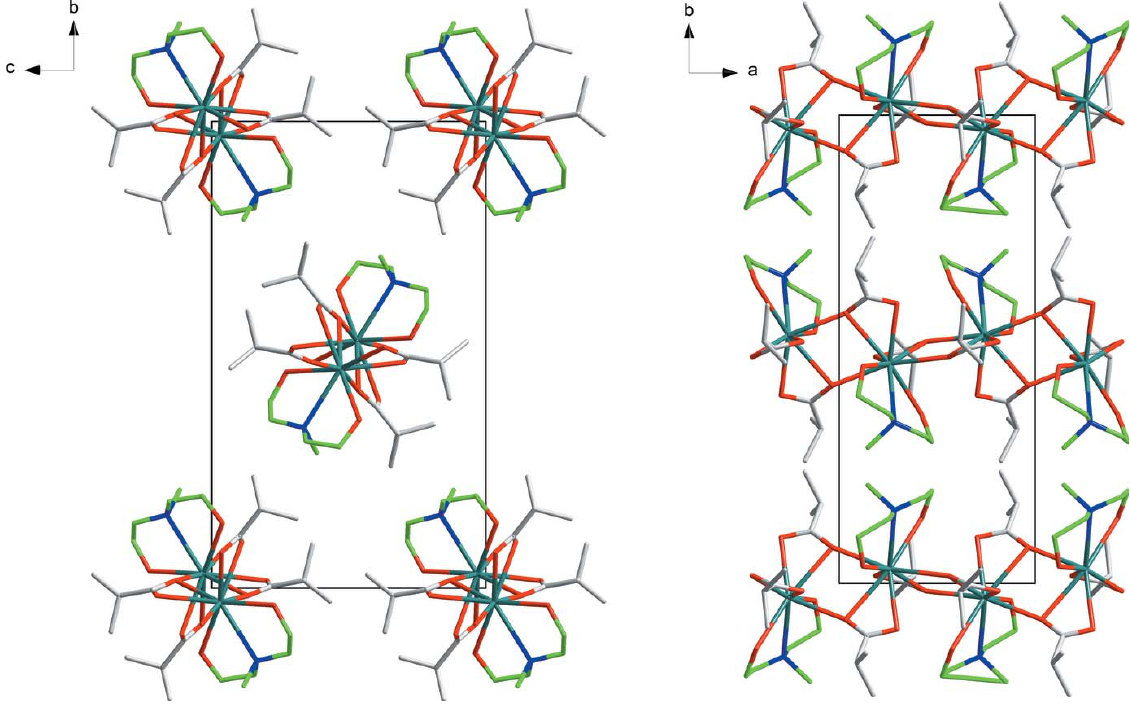
Figure 4 Packing diagram of I , viewed down the a axis (left) and the c axis (right). Color code: Sr teal, C (ib) gray, C (H 2 mda) green, N blue, O red. H atoms and disordered fragments are omitted for